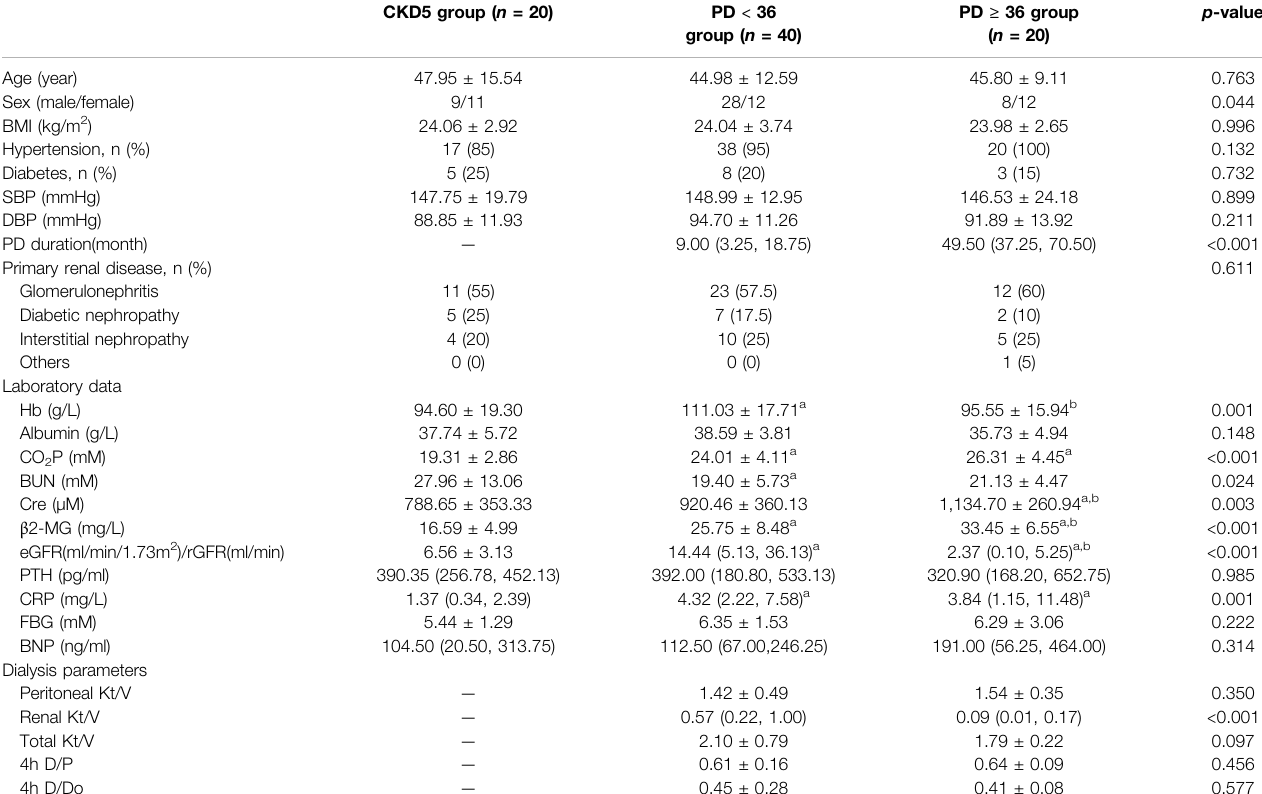
TABLE 1 | Individual baseline characteristics in different